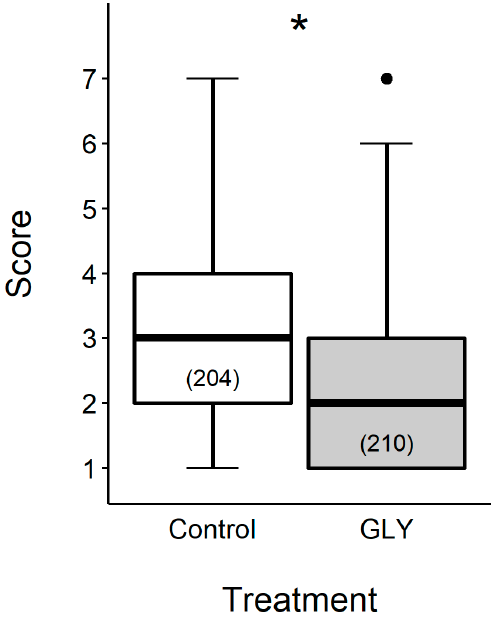
Figure 5. Effect of chronic exposure to GLY on young honey bee sucrose responsiveness. Gustatory response score of five, nine and fourteen day old bees reared in cages that were offered sucrose solution alone (control) or with GLY (2.5 mg L − 1 ). Thick line, box and whiskers represent median, inter-quartile range and data range excluding extreme data (points), respectively. Numbers inside boxes indicate sample size. * indicates an e ff ect of GLY (therefore, di ff erences between its two levels), given that this factor is included in the minimal adequate model (MAM). Minimal adequate model (GLMM with binomial structure): Score ∼ GLY + cage. Black circle represents